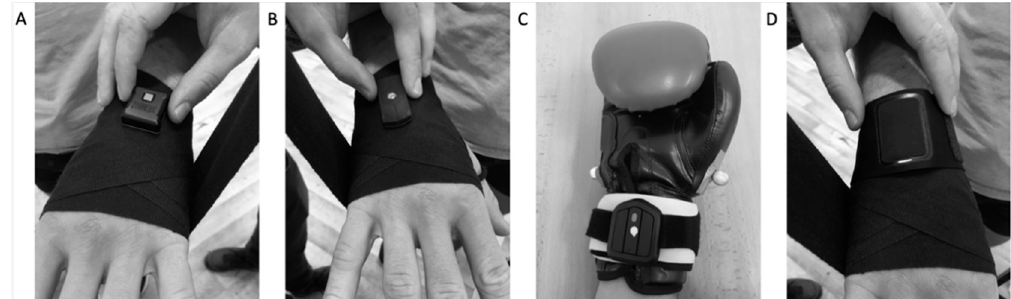
Figure 1. Punch tracker placement: ( A ) the StrikeTec punch tracker inserted directly on top of the wrist, under 2.5 m hand wraps, and under the gloves; ( B ) the Hykso punch tracker inserted directly on top of the wrist, under 2.5 m hand wraps, and under the boxing gloves; ( C ) the Everlast punch tracker attached on the wrist on the surface of the wrist flexors on boxing gloves in their respective wristbands; and ( D ) the Corner punch tracker inserted directly on top of the wrist, under 2.5 m hand wraps, and under gloves, in their respective wristbands.